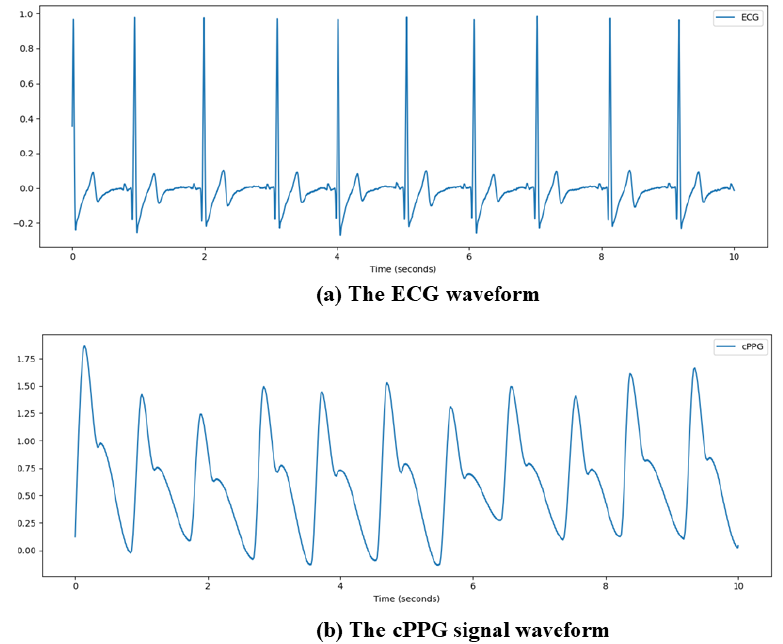
Figure 1. Signal waveform obtained by ECG and cPPG